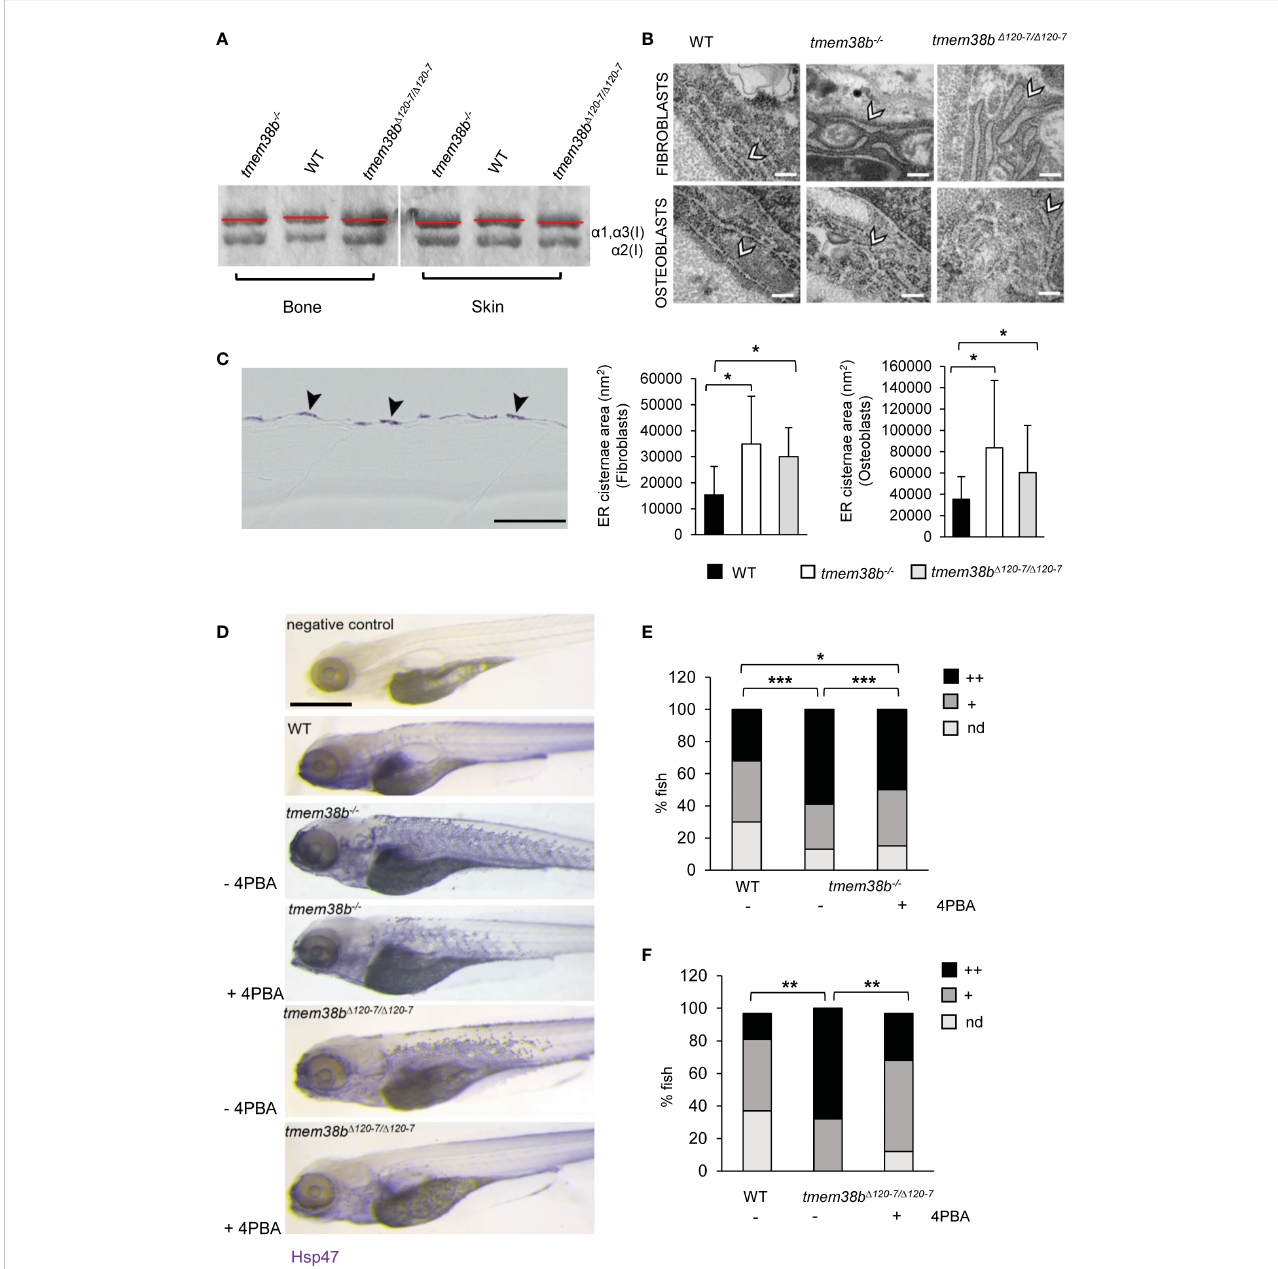
FIGURE 4 Collagen type I and ultrastructural analysis. (A) Representative Coomassie stained SDS-Urea-PAGE of collagen type I extracted from WT (n = 2) and mutants ( tmem38b -/- n = 2; tmem38b D 120-7/ D 120-7 n = 2) bone and skin. Mutants ’ collagen a bands presented a slight faster migration compared to WT as highlighted by red lines. (B) Transmission electron microscopy images of 1 mpf WT (n = 3), tmem38b -/- (n = 3), and tmem38b D 120-7/ D 120-7 (n = 3) fi broblasts and osteoblasts at the vertebral endplate. ER cisternae enlargement was evident in mutants (arrowheads). Magni fi cation 80000x. Scale bar: 200 nm. The ER cisternae area quantitation is shown in the graphs (bottom). (C) Immunohistochemistry of 5 dpf WT and tmem38b -/- with Hsp47b antibody. High magni fi cation details of the skin of WT and tmem38b -/- following immunostaining with Hsp47b antibody revaled that Hsp47 signal was located in the fi broblasts of the skin (arrowheads). ( D) Representative images of 5 dpf fi sh after whole mount immunohistochemistry with Hsp47b antibody, before and after 4PBA administration. Scale bar: 500 m m. (E) Analysis of Hsp47b expression by whole mount immunohistochemistry in WT and in tmem38b -/- before and after 4PBA administration. A signi fi cant increase of Hsp47 signal was detected in tmem38 -/- compared to WT. 4PBA treatment signi fi cantly reduced the Hsp47b signal in tmem38b -/- compared to untreated mutant fi sh without reaching WT value (WT n = 146 and tmem38b -/- n = 116 untreated and 4PBA treated tmem38b -/- n = 113). (F) Analysis of Hsp47b expression by whole mount immunohistochemistry in WT and in tmem38b D 120-7/ D 120-7 before and after 4PBA administration. A signi fi cant increase of Hsp47 signal was present in tmem38b D 120-7/ D 120-7 compared to